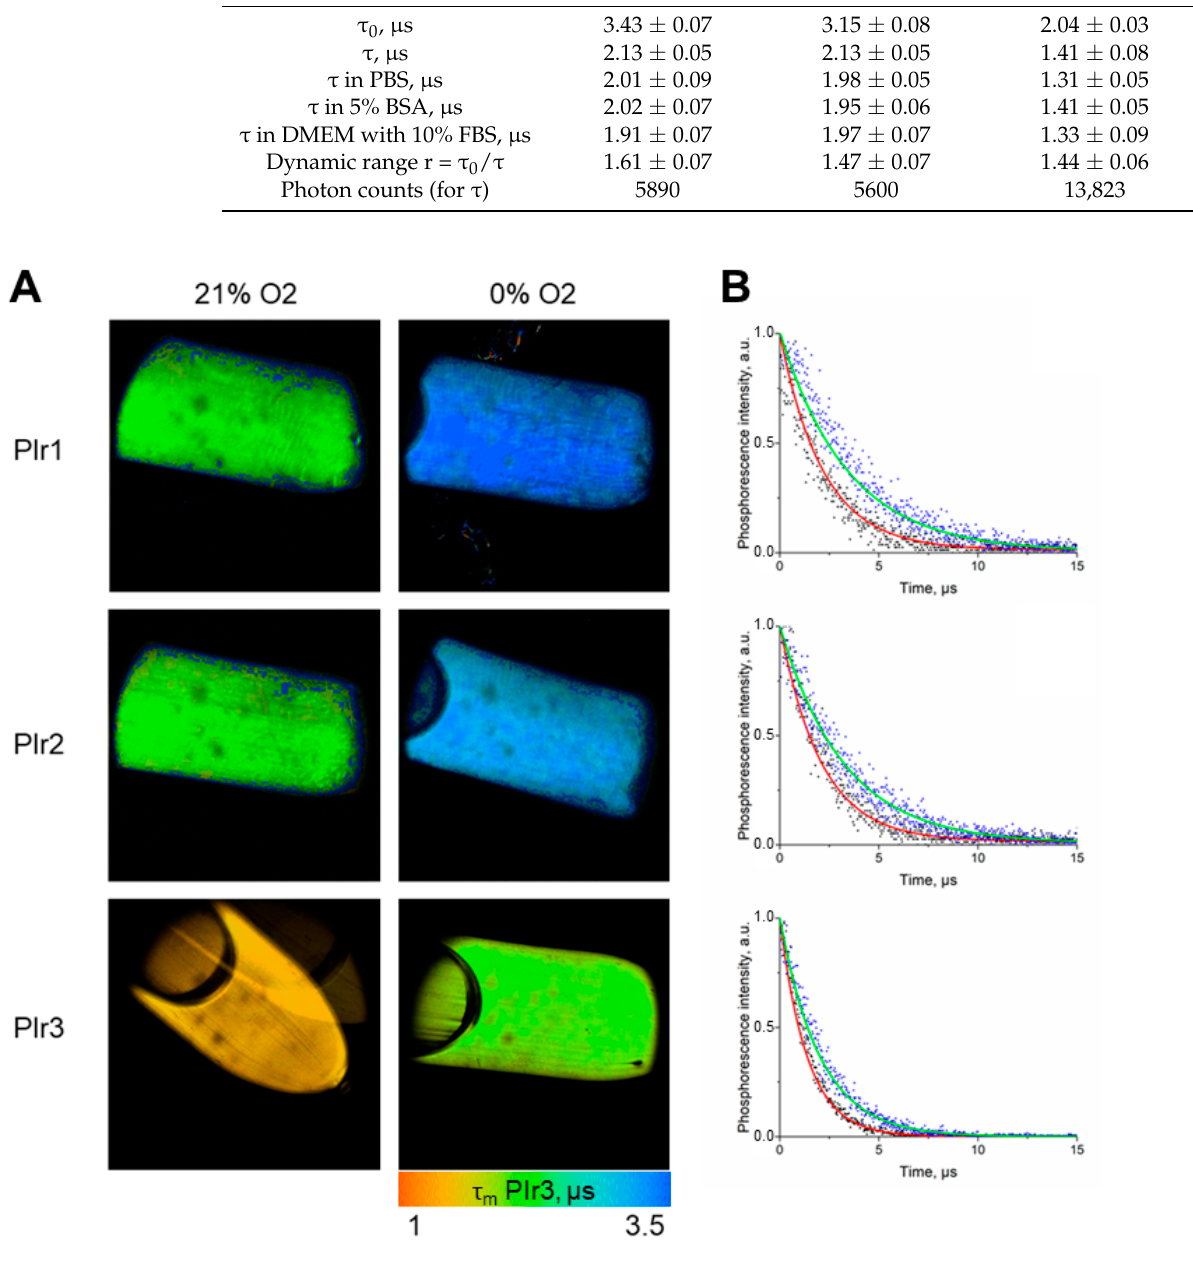
Figure 5. Phosphorescence lifetime measurements for PIr1, PIr2 and PIr3 in degassed and aerated aqueous solutions. ( A ) PLIM images of the tubes with solutions. Image size is 16 × 16 mm. ( B ) Phosphorescence decay curves of PIr1–PIr3 probes. On the phosphorescence decay curves, photons are indicated by dots (black—21% O 2 ; blue—0% O 2 ), and the lines indicate the mono-exponential phosphorescence decay curve (the red line is 21% O 2 ; the green line is 0% O 2 ).